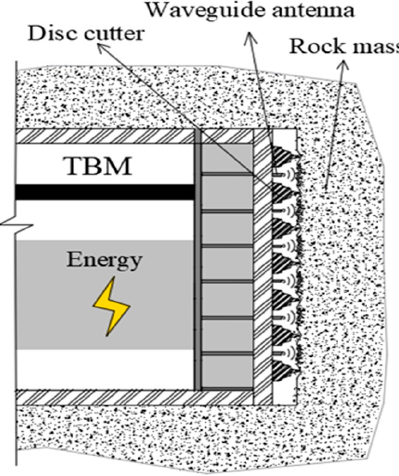
Figure 1. Schematic diagram of “microwave and mechanical” excavation.